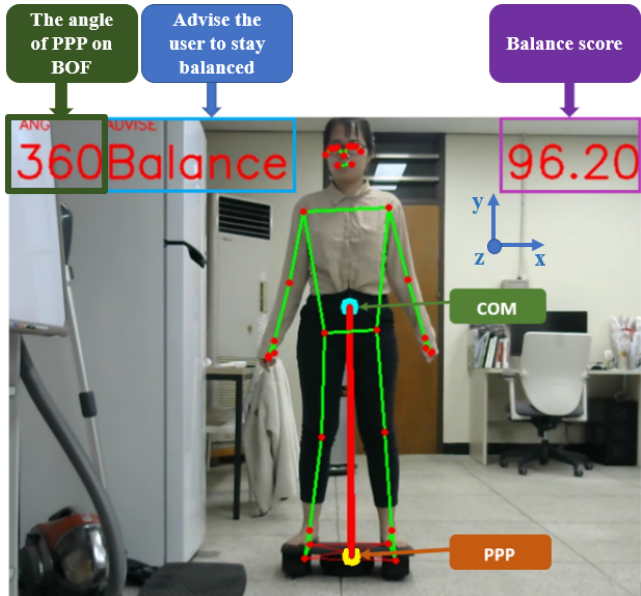
Figure 7. The results of the specifications were displayed on the screen of the scoring system.